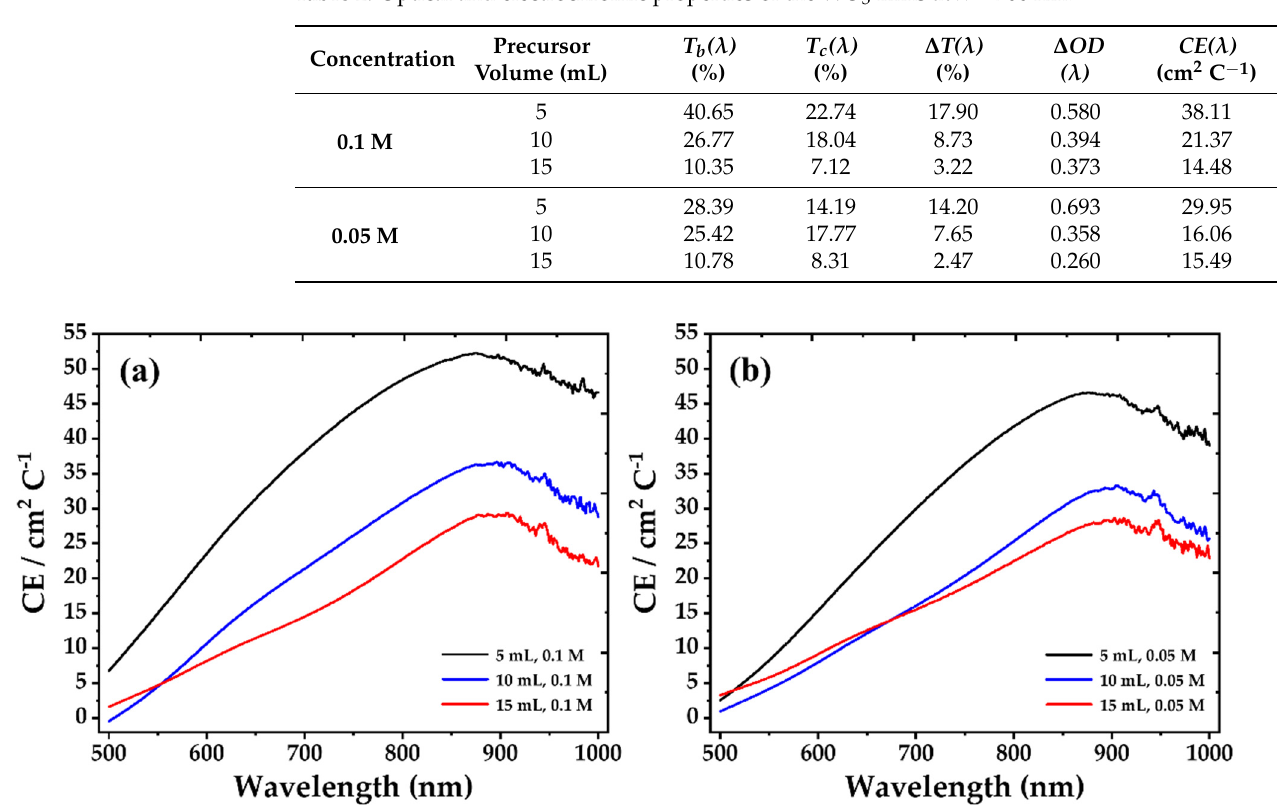
Figure 5. Multiple cyclic voltammetry experiments (scans) of WO 3 film with 0.1 M (5 mL) at a scan- ning speed of 10 mV sec − 1 (stability experiment).